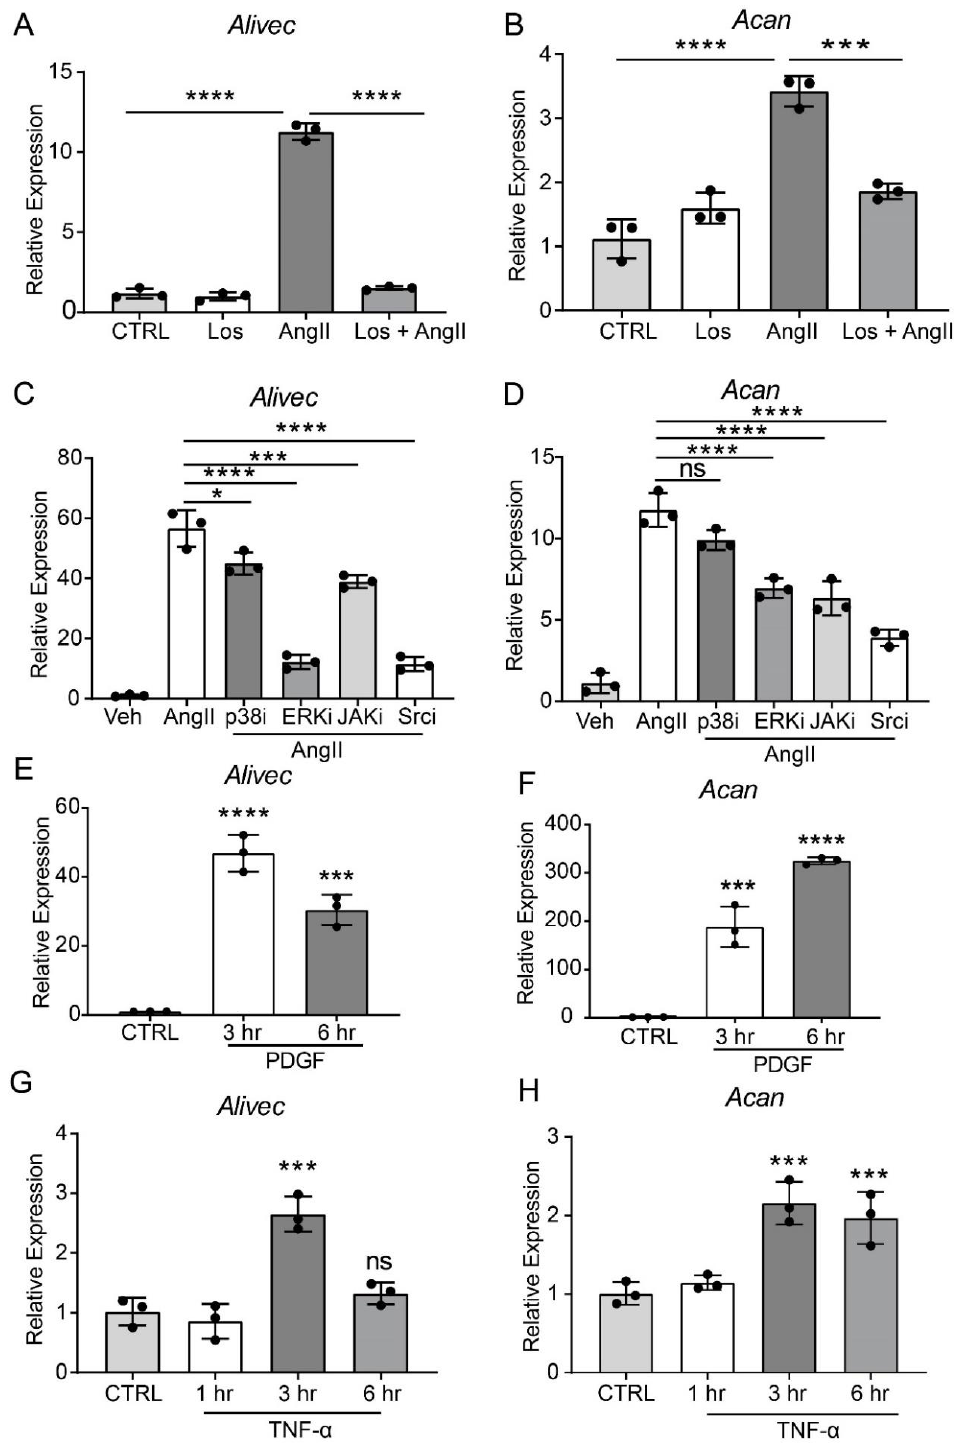
Figure 2. AngII-induced Alivec expression is regulated by AT1R and downstream kinases Src and ERK1/2. ( A , B ) RT-qPCR analysis of Alivec and Acan expression in RVSMCs pre-treated with the AT1R inhibitor Losartan (Los, 10 µM) for 30 min, followed by AngII treatment (100 nM, 3 h). ( C , D ) RVSMCs were pre-treated with vehicle DMSO (Veh) or inhibitors (i) of p38, ERK1/2, JAK and Src kinases for 30 min, followed by AngII treatment (100 nM, 3 h). ( E – H ) RT-qPCR analysis of Alivec and Acan expression in RVSMCs, treated with PDGF (10 ng/mL) and TNF- α (10 ng/mL). Data presented as mean ± SD. Comparisons were performed by one-way ANOVA with Tukey’s post-hoc test. ( A – D ) Dunnett’s multiple comparisons test ( E – H ), * p < 0.05, *** p < 0.001 and **** p < 0.0001 vs. CTRL or